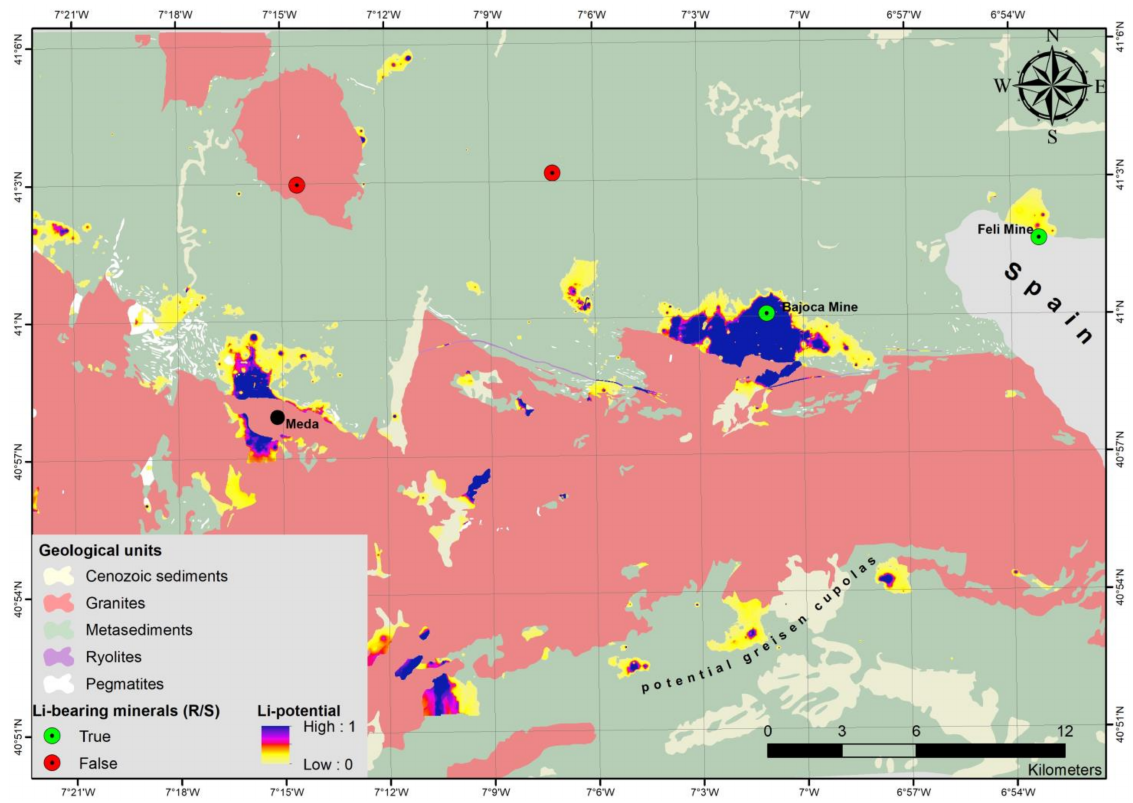
Figure 12. Predicted Li mineralisation based on geological and remote sensing